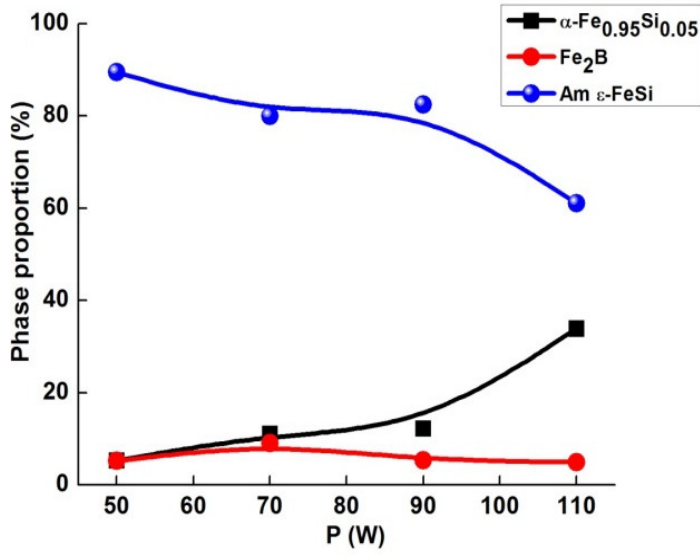
Figure 4. Evolution of the volumetric fraction of the phases versus the laser power.